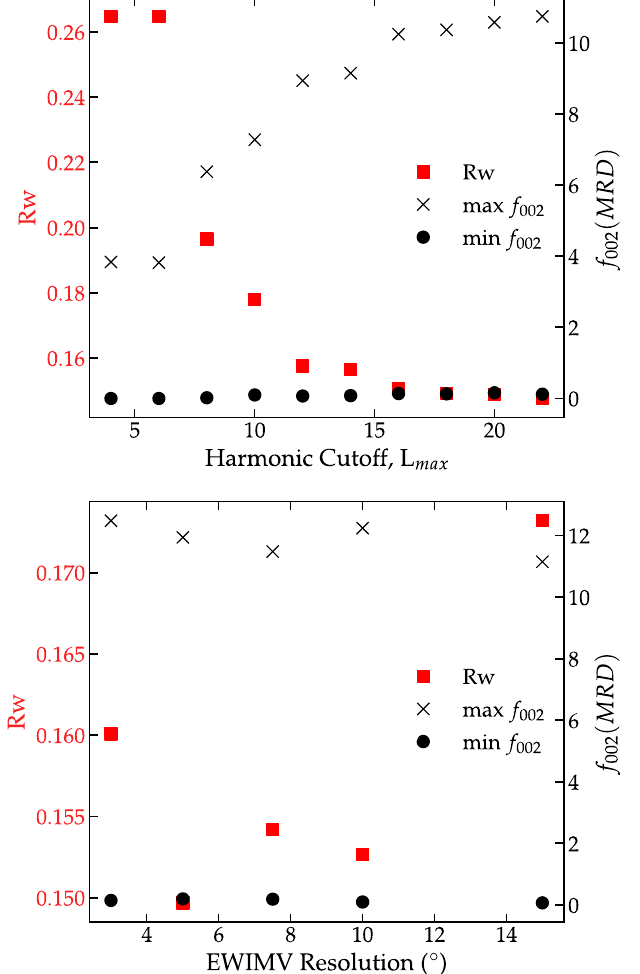
Figure 3. Comparison of the effect of spherical harmonic order ( top ) and EWIMV ODF resolution ( bottom ) on the texture and refinement error of BNT-BT-KNN sintered ceramics. Min and Max of f 002 , refinement error Rw are plotted against harmonic cutoff and EWIMV resolution.